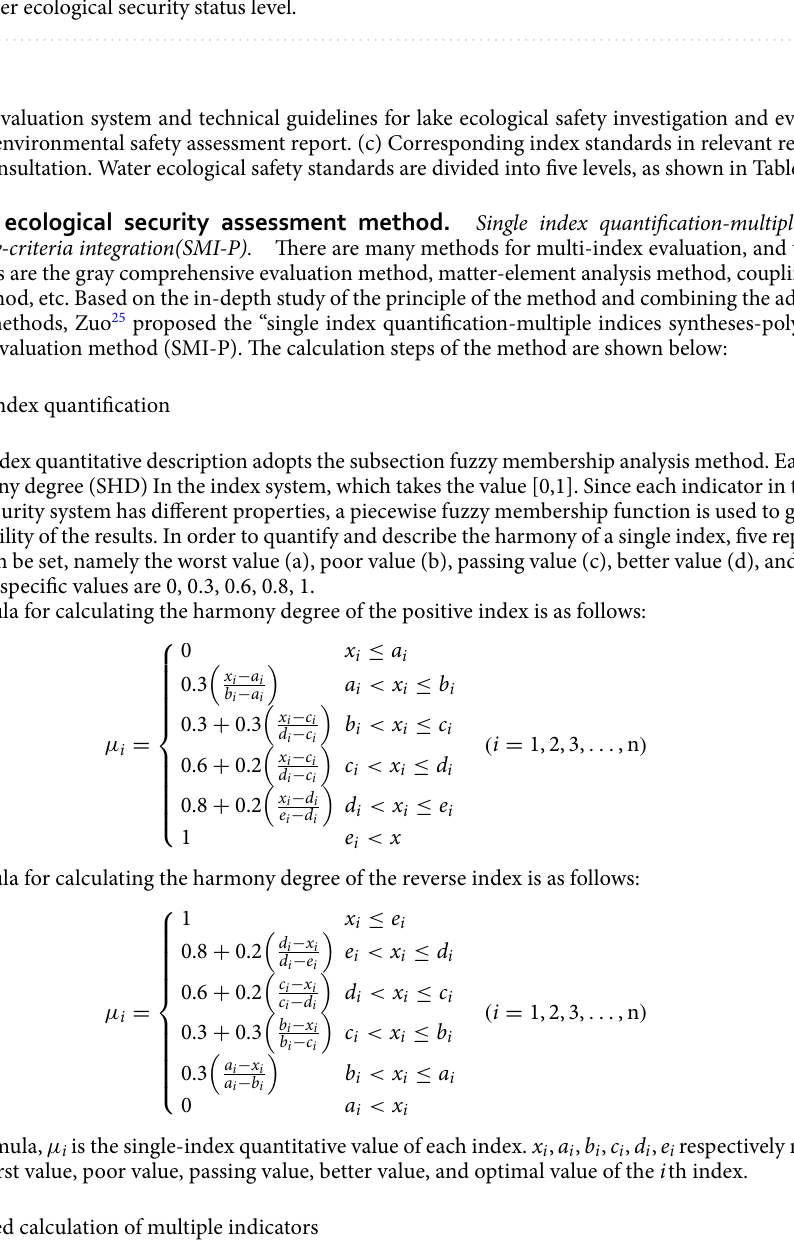
Table 2. Water ecological security status